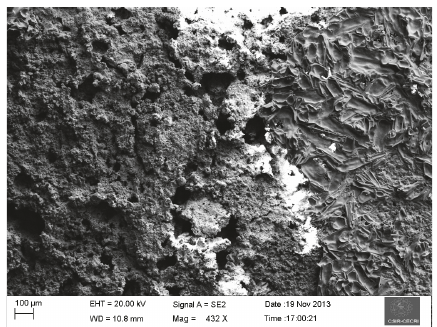
Figure 5: Surface morphology of SrTiO 3 after being subjected to hot corrosion in Na 2 SO 4 + 50 wt.% V 2 O 5 environment at 900 ∘ C. A porous layer and corrosion products were observed on the